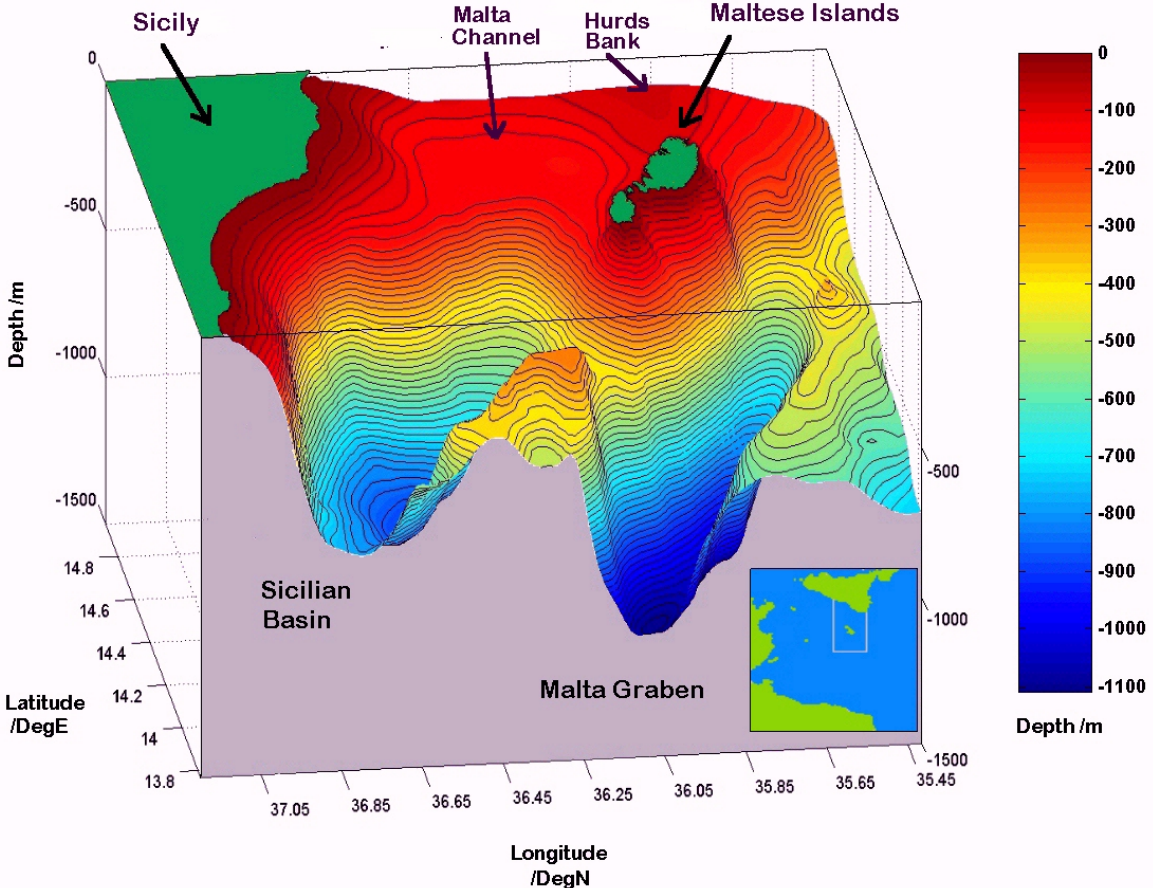
Fig. 1. Three-dimensional view of the model bathymetry (based on the U.S. Navy DBDB1 data